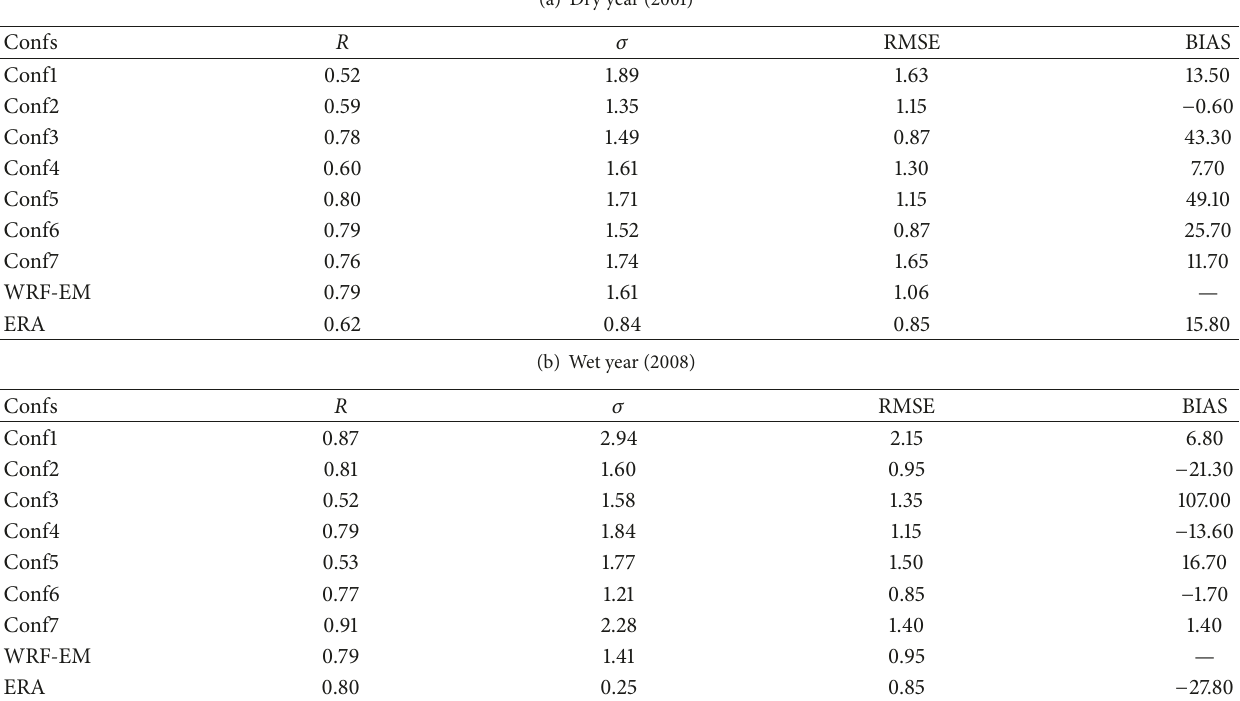
Table 6: The four different statistic, for the transitional zone, (a) for the dry year and (b) for the wet